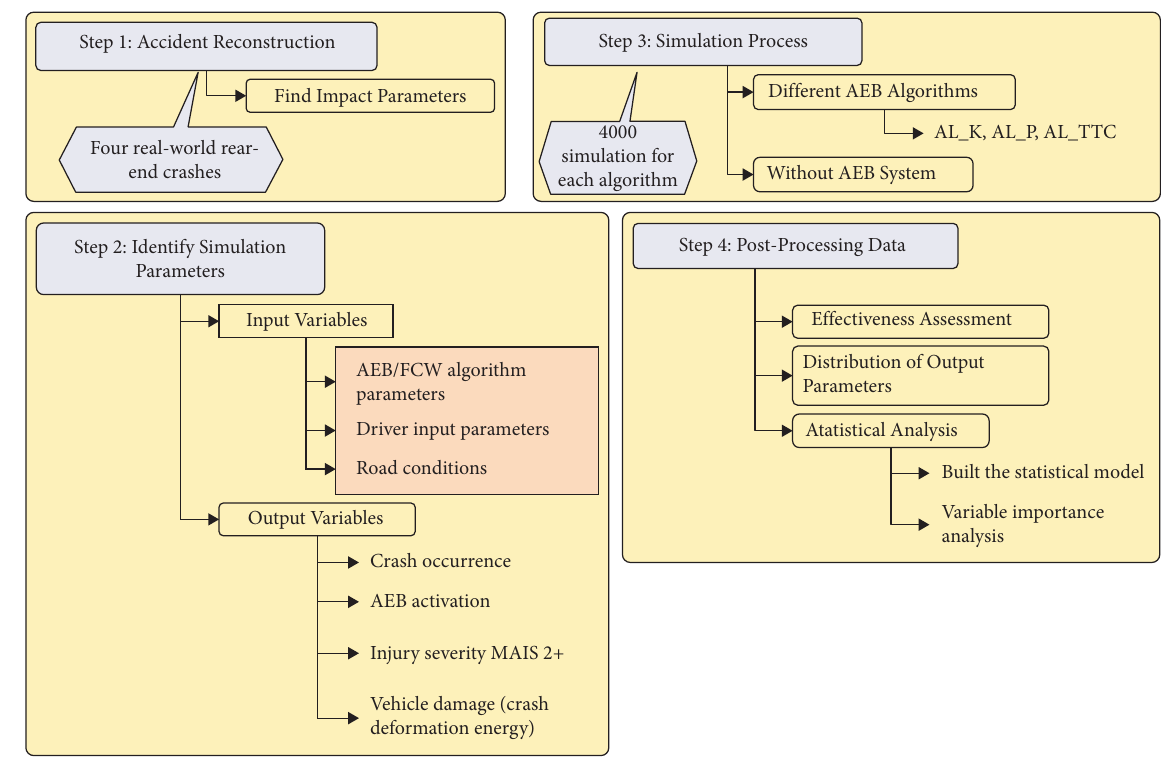
Figure 2: Research steps. Table 2: Information of real-world rear-end crash